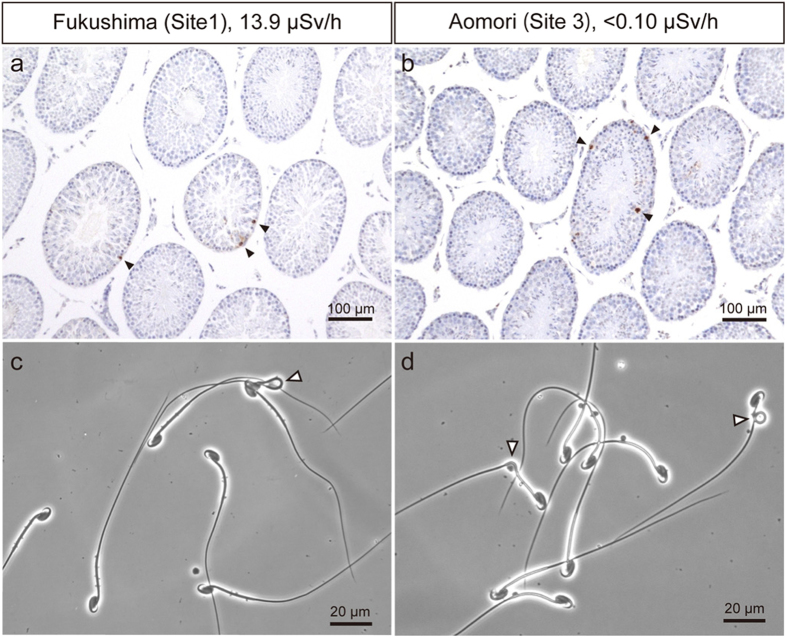
Apoptosis in male germ cells, and morphology of epididymal spermatozoa in wild large Japanese field mice captured at Fukushima (Site 1) and Aomori (Site 3) in 2013.(a,b) Terminal deoxynucleotidyl transferase-mediated dUTP nick end labeling (TUNEL) staining and hematoxylin counterstaining of seminiferous tubules (Solid arrowheads: Apoptotic cells). (c,d) Phase-contrast micrograph of spermatozoa (Open arrowheads: spermatozoa with abnormal morphologies).